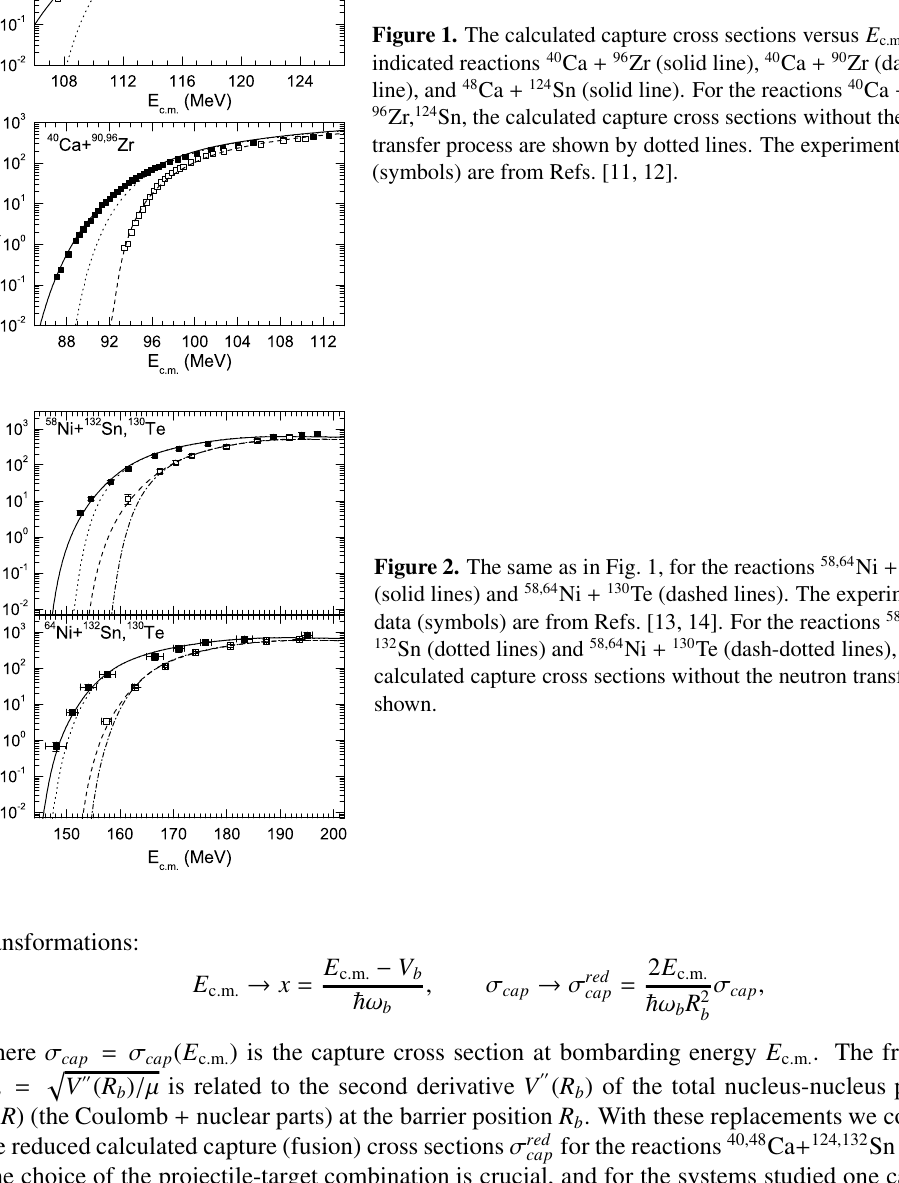
Figure 1. The calculated capture cross sections versus E c . m . for the indicated reactions 40 Ca + 96 Zr (solid line), 40 Ca + 90 Zr (dashed line), and 48 Ca + 124 Sn (solid line). For the reactions 40 Ca + 96 Zr, 124 Sn, the calculated capture cross sections without the neutron transfer process are shown by dotted lines. The experimental data (symbols) are from Refs. [11, 12].